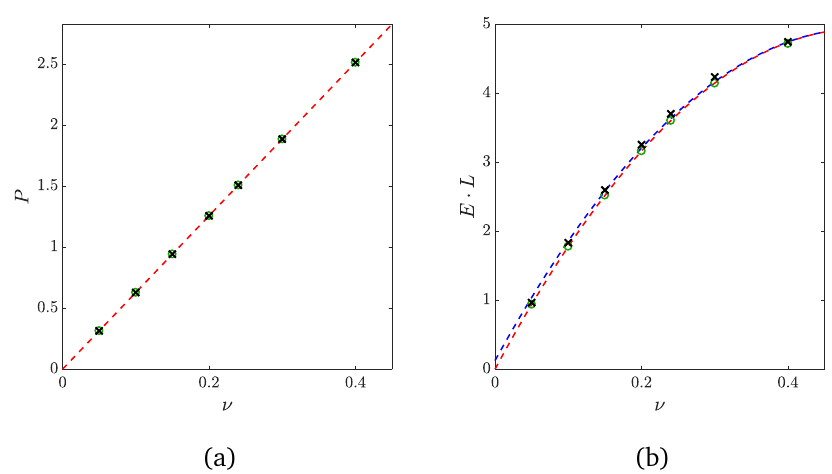
Figure 3: (a) Comparison between momentum of a one-cut solution with mode num- ber n = 1 (red dashed line, for both the isotropic and anisotropic interaction δ ) and momenta of the corresponding quantum eigenstates (shown for different system sizes L = M /ν , with M = 30 and filling fraction ν ), with green (black) circles representing the isotropic (anisotropic, with δ = 1) cases. (b) Comparison between energies of a one-cut solution with mode number n = 1 (red dashed line for isotropic case and blue dashed line for anisotropic case with δ = 1) and rescaled energies ( E · L ) of the corresponding quantum eigenstates (the same system sizes as in panel